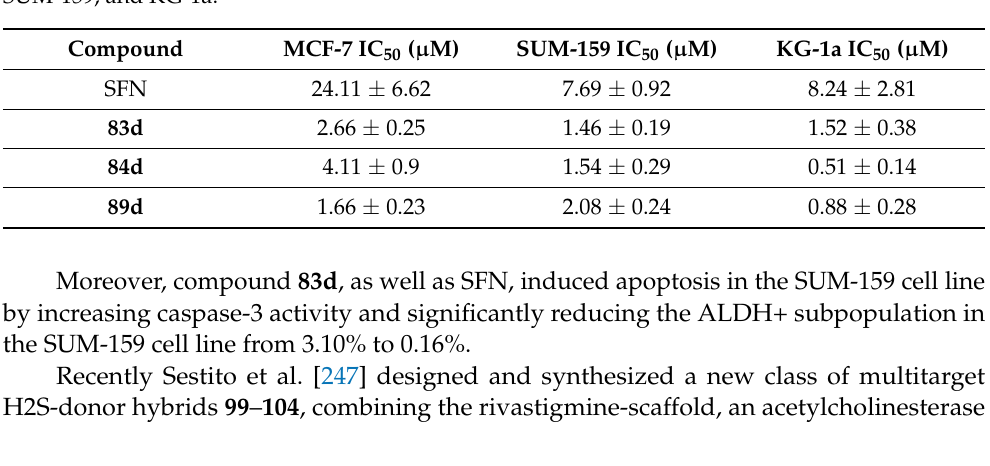
Figure 24. Synthesis of sulfone analogues of SFN 89d – e . The series of SFN analogues with heterocyclic moieties 83a – e , 84a – e , and 89a – e were evaluated for their anticancer activities (breast cancer cell lines MCF-7 and SUM-159, acute leukemia stem cell-like cell line, and KG-1a). Among all synthesized analogues, tetrazole analogues 83d , 84d , and 89d were generally the most potent—and significantly more active—than SFN against the tree cancer cell lines (Table 4). Table 4. Inhibitory effects of tetrazole analogues of SFN 83d , 84d , and 89d and SFN on MCF-7, SUM-159, and